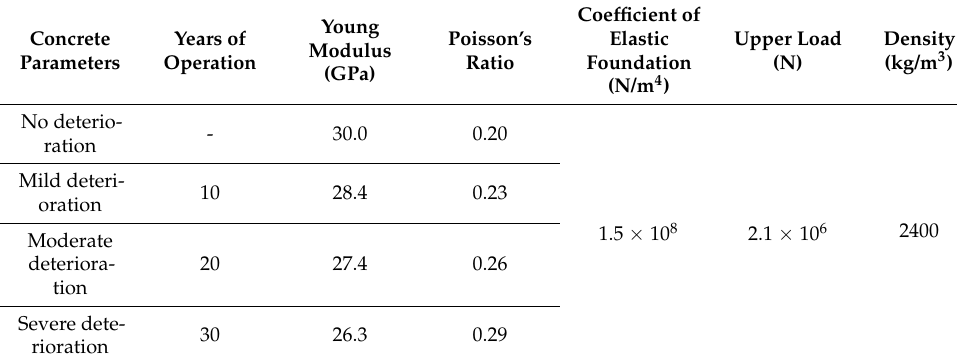
Figure 19. Stress and width of tensile zone after deterioration. In this paper, we have used a linear analysis model to analyze the influence of the deterioration of lining concrete on the structure, and predicted the lining cracks. In actual engineering, concrete is a nonlinear material, and the results of a linear model will deviate